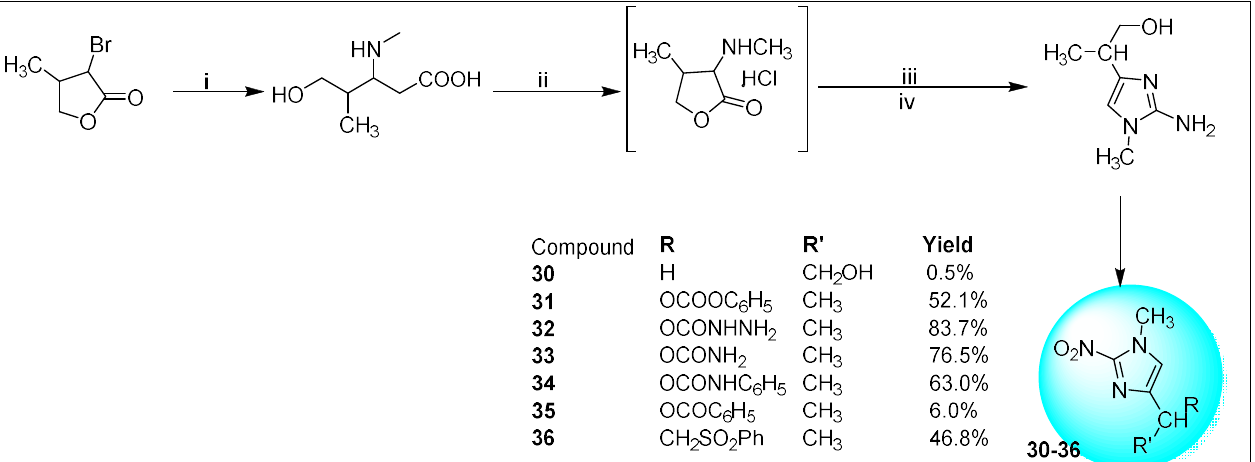
Scheme 10. Synthesis of 4-substituted 2-nitromimdazole derivatives. Reagents and conditions: ( i ) CH 3 NH 2 , ( ii ) HCl/EtOH, ( iii ) HgNa/EtOH, ( iv ) NH2CN (yields not reported), ( v ) HBF 4 , NaNO 2 , Cu, NaNO 2 (yields given above). Table 2. In vitro and in vivo antibacterial activities.